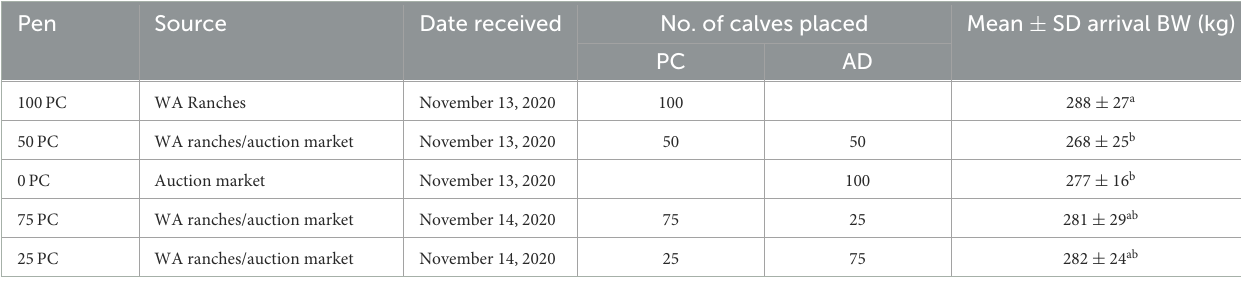
TABLE 1 Details of filling of pen with source of calves received at the feedlot.